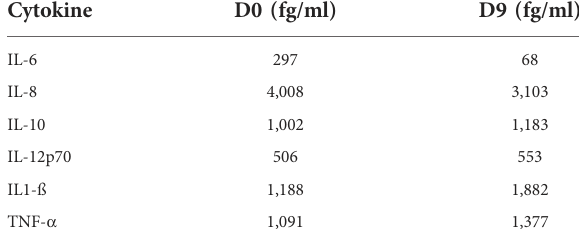
TABLE 1 Concentrations of the cytokines IL-1ß, IL-6, IL-8, IL-10, IL- 12p70 and TNF- α were assessed pre-treatment at D0 and D9 in regular use of Theracurmin® 2-g every 12